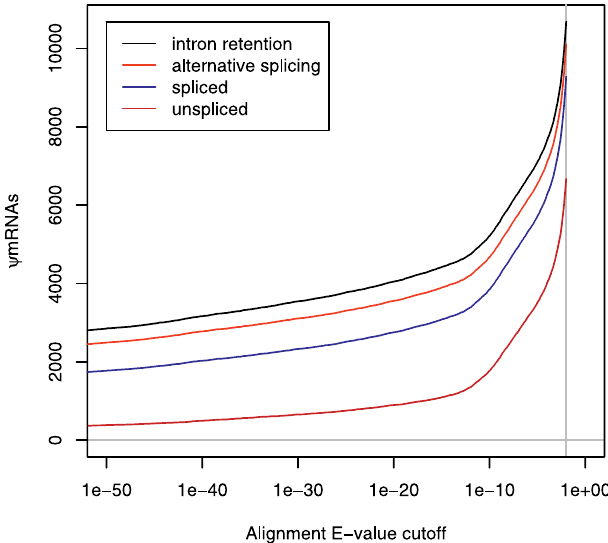
Figure 1. Number of w mRNAs as a Function of Alignment E -Value Cutoff DOI: